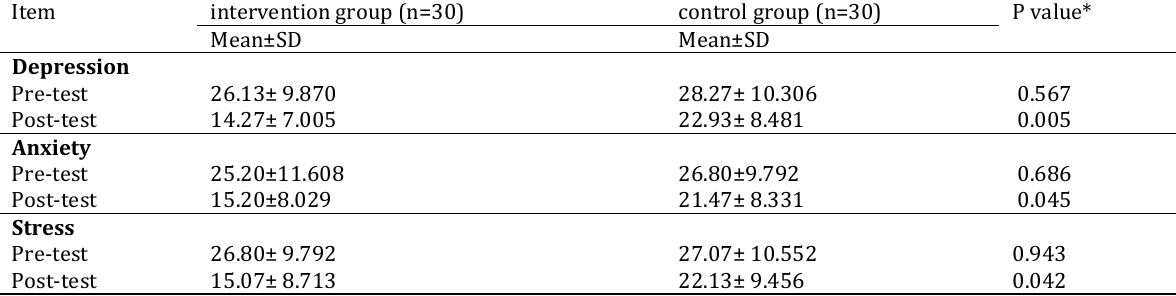
Table 3. Total score (mean) of the intervention group and the control